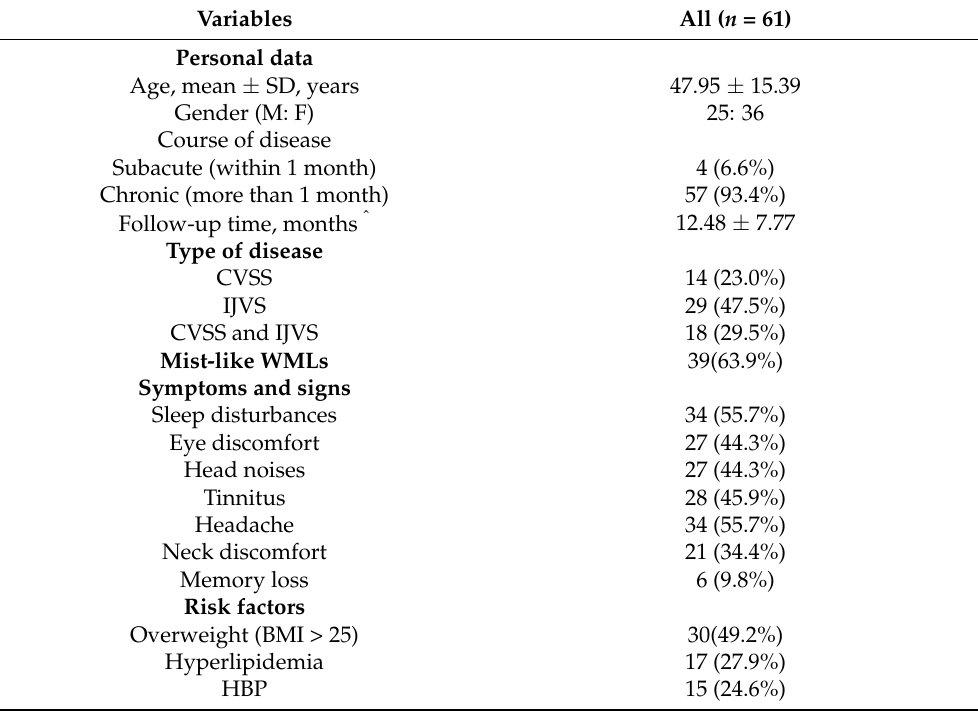
Table 1. Demographic and basic clinical